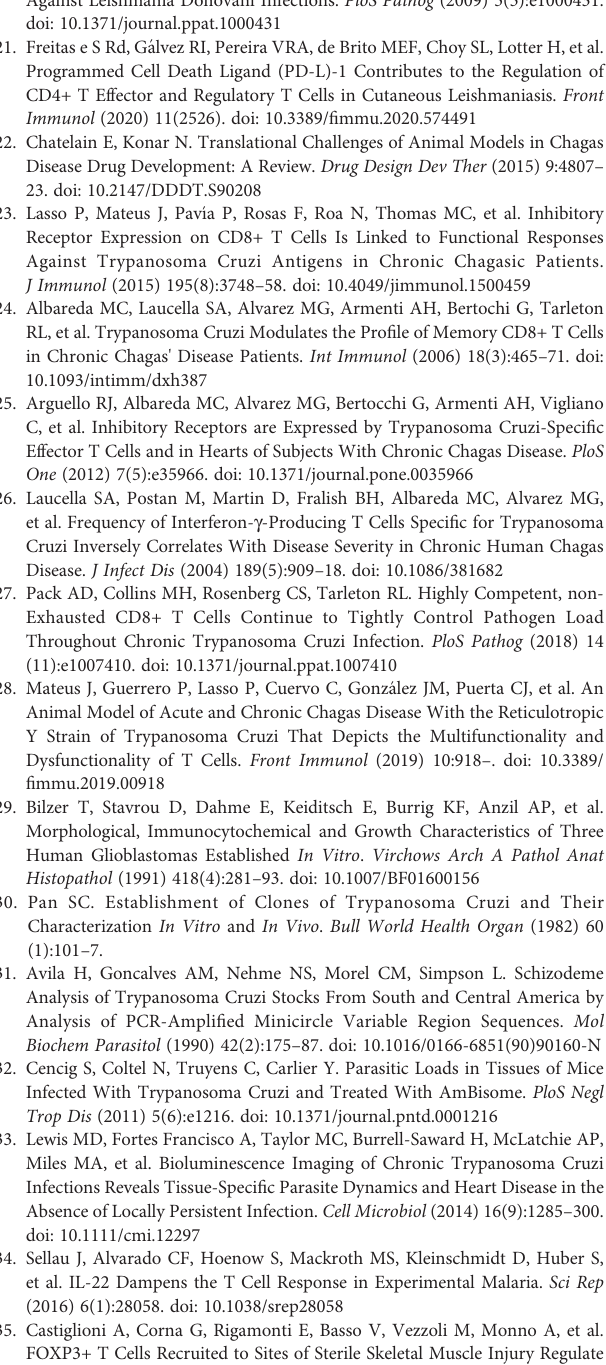
Supplementary Figure 6 | Stimulation of T cells derived from muscle tissue of infected CD45.2 mice with T. cruzi lysate-pulsed splenocytes from CD45.1 mice as